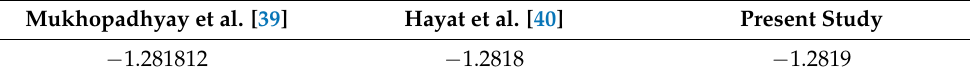
Table 2. Comparison of the f (cid:48)(cid:48) ( 0 ) values for Newtonian fluid when Ri = 0, N = 0, Sc = 0,0,